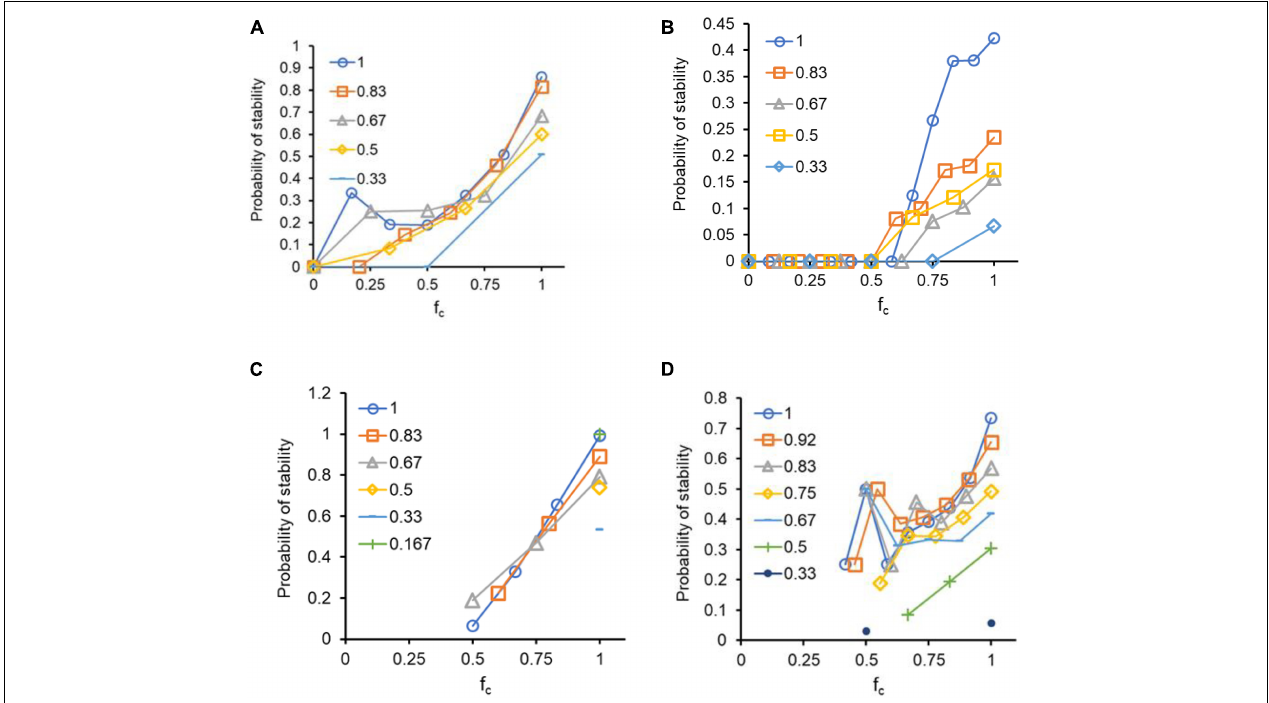
FIGURE 5 | Cooperative interactions help the system retain diversity. Upon removal of a species from an N- sized network, the remaining N - 1 species are allowed to reach the new equilibrium. If the new steady state comprises of all N - 1 species, the system is classified as stable. (A) Three-species network, and (B) four-species network when analyzed in a replicator equation framework. (C) Three-species network, and (D) four-species network when analyzed in a Lotka-Volterra framework. All interactions are sampled from exponential distributions. The data represents data from 1,000 simulations of randomized P matrices for each pair of c and f c . The legend describes the value of c for each set of